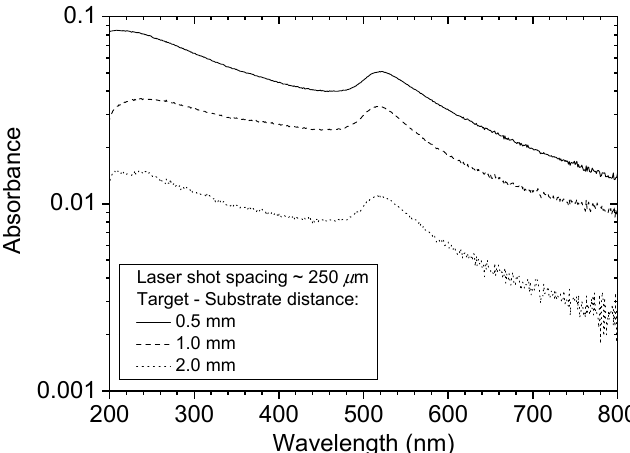
Figure 5. UV / visible absorbance spectra of films deposited at 0.5 mm, 1.0 mm and 2.0 mm separation, using a laser shot spacing of 250 μ m.